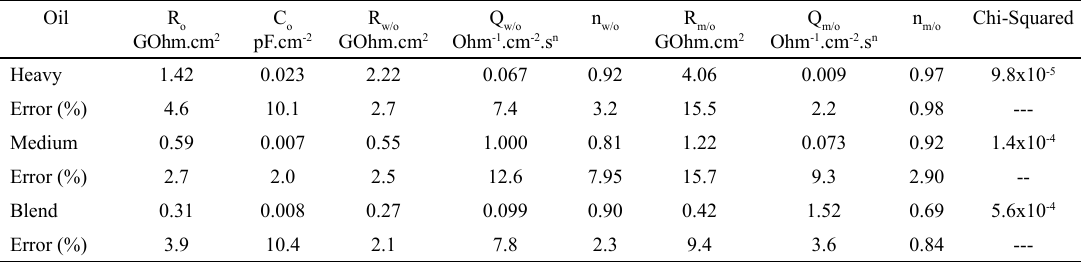
Table 2. Simulation values of equivalent circuit for AISI 1020 steel in heavy, medium and blend petroleum. Oil R o GOhm.cm